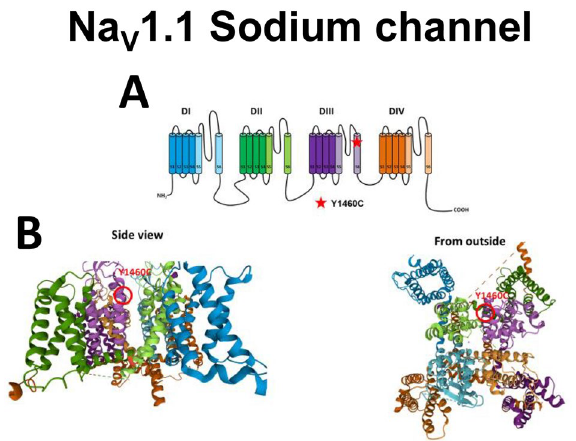
Figure 1. Localization of the Y1460C mutation in the Na V 1.1 channel. ( A ) Schematic of the secondary structure of the Na V 1.1 voltage-gated sodium channel. The four homologous domains (DI–DIV), the transmembrane segments (S1–S6), and the extra- and intracellular linkers are shown. The four domains are indicated by different colors while the transmembrane segments forming the pore domain (PD) are indicated by lighter colors. The position of Y1460C is indicated. (B) Structural model from Na V 1.1 Cryo-EM showing the localization of the Y1460C residue with inside and outside